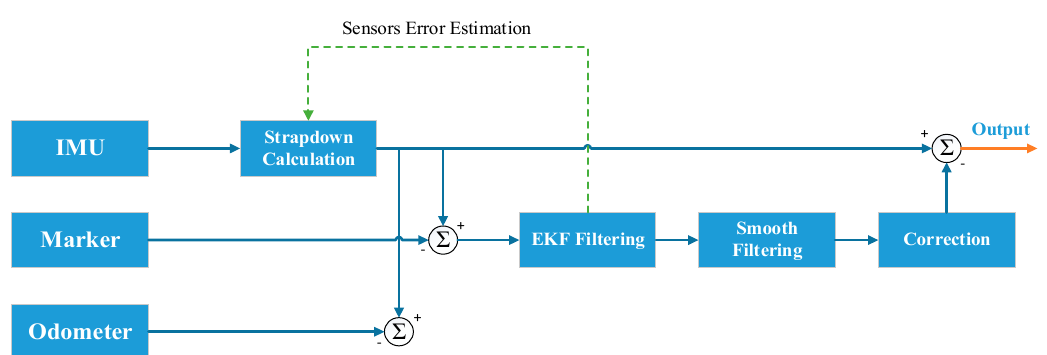
Figure 6. Formation of IMU module.